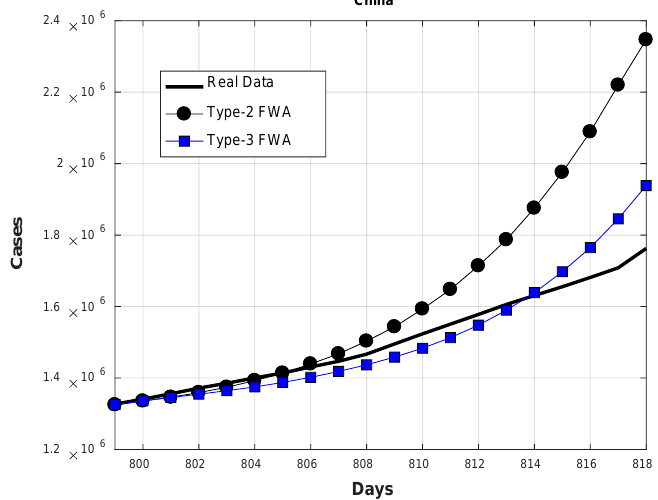
Figure 20. Future prediction (China).